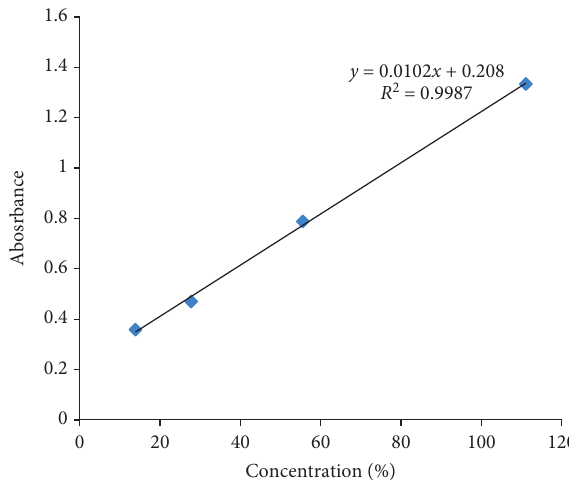
Figure 2: Calibration curve for dissolution study of ethambutol hydrochloride 100mg tablet